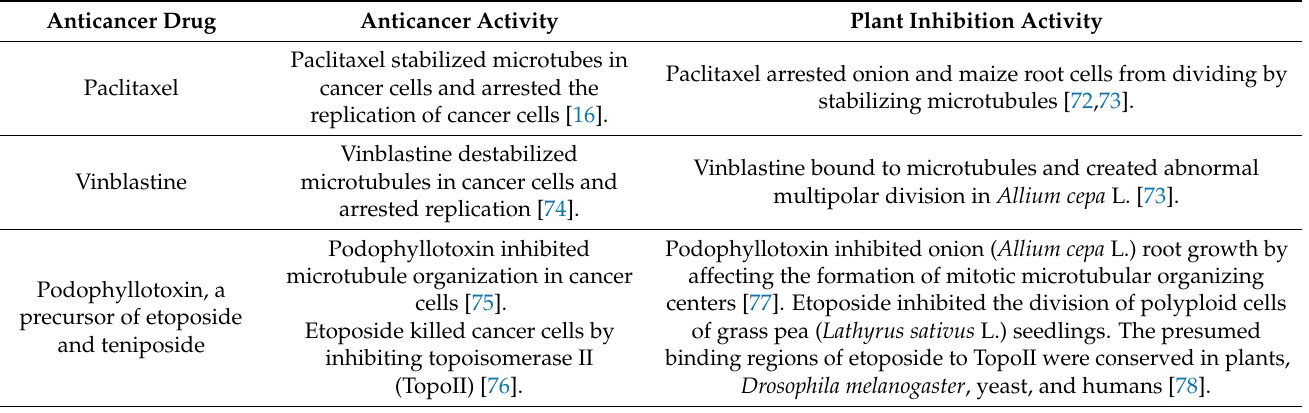
Table 1. Inhibitory plant activities of clinically used, naturally occurring compounds or their precursors.